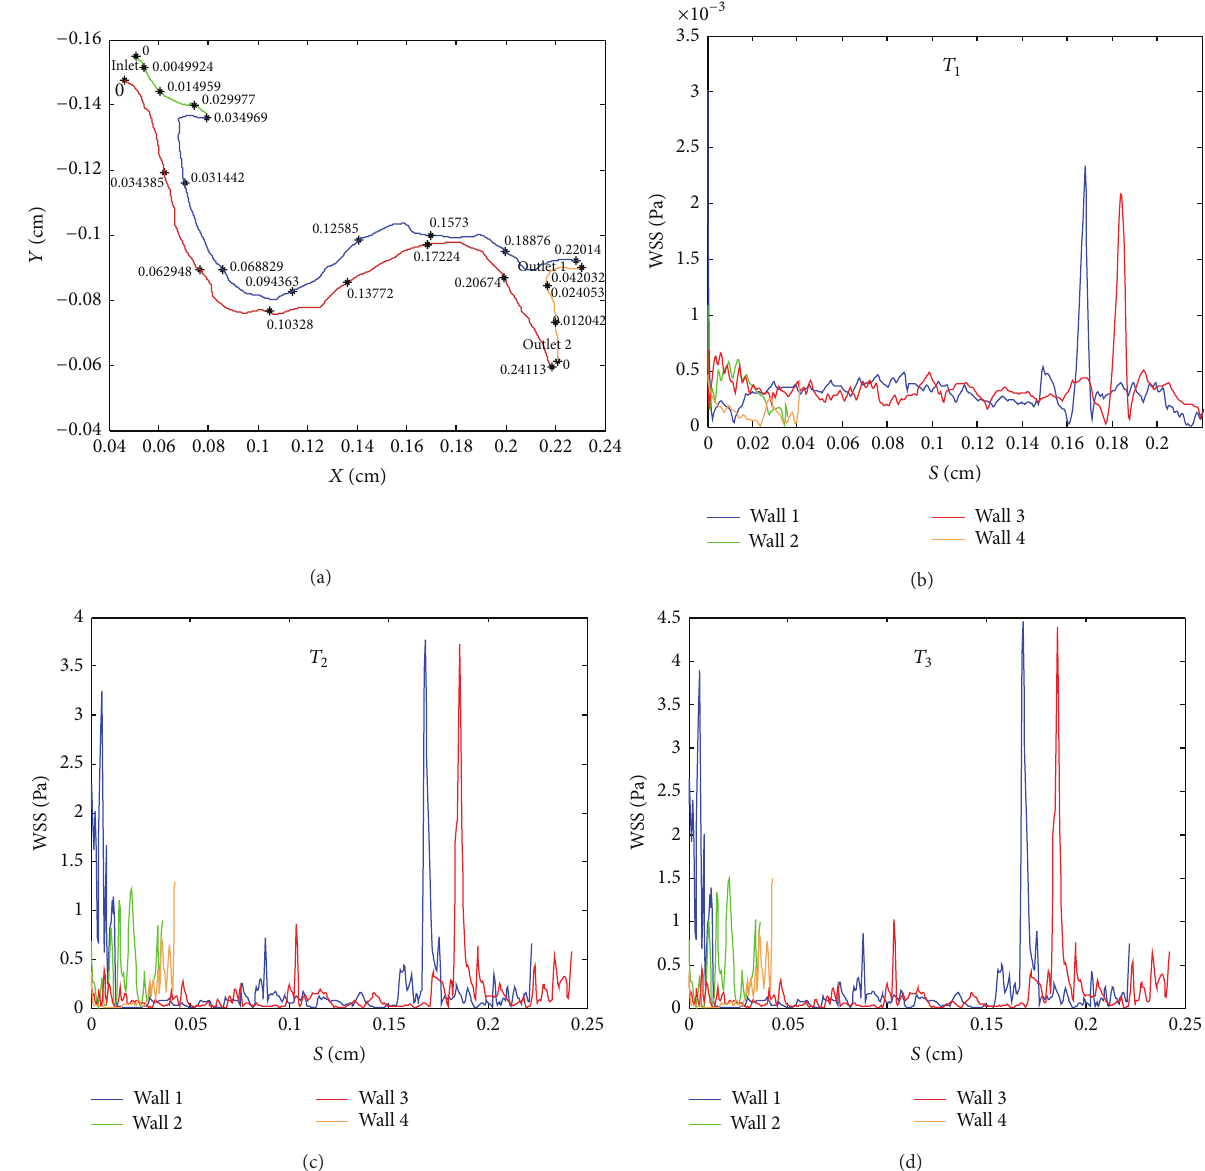
Figure 4: (a) Boundary plots of the coronary arterial walls 1, 2, 3, and 4 shown in red, green, blue, and brown, respectively. (b)–(d) WSS distribution along coronary walls at time 𝑇 1 , 𝑇 2 , and 𝑇 3 ,